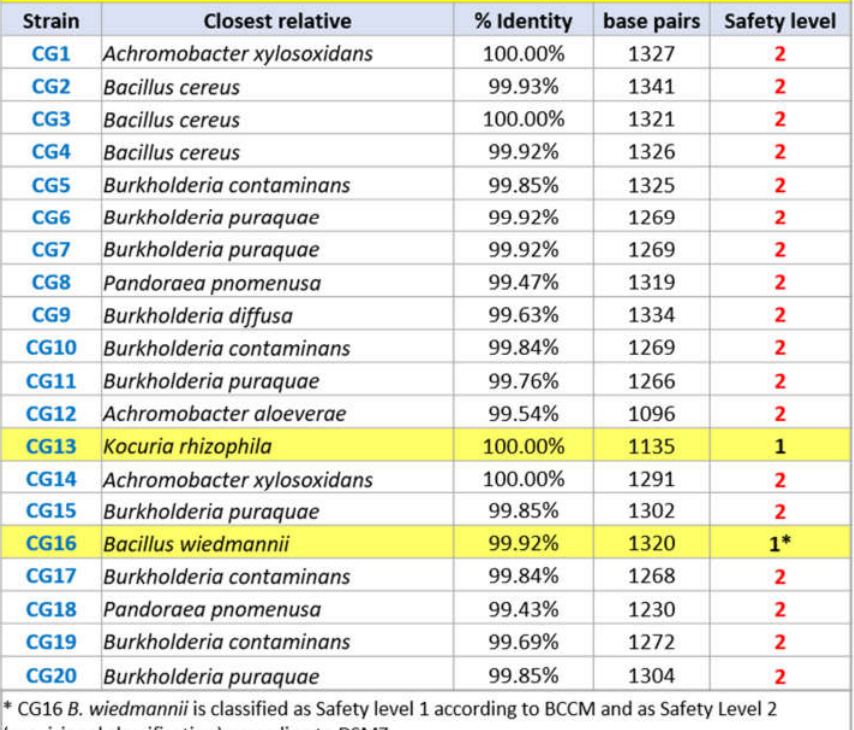
“Classification of Prokaryotes—Bacteria and Archaea—into Risk Groups”, TRBA 466; www.baua.de/abas, accessed on 20 February 2022; Leibniz Institute DSMZ, German Collection of Microorganisms and Cell Cultures GmbH https://www.dsmz.de/, accessed on 20 February 2022; BCCM: Belgian Coordinated Collections of Micro-organisms https://bccm.belspo.be/, accessed on 20 February 2022)) are also shown.